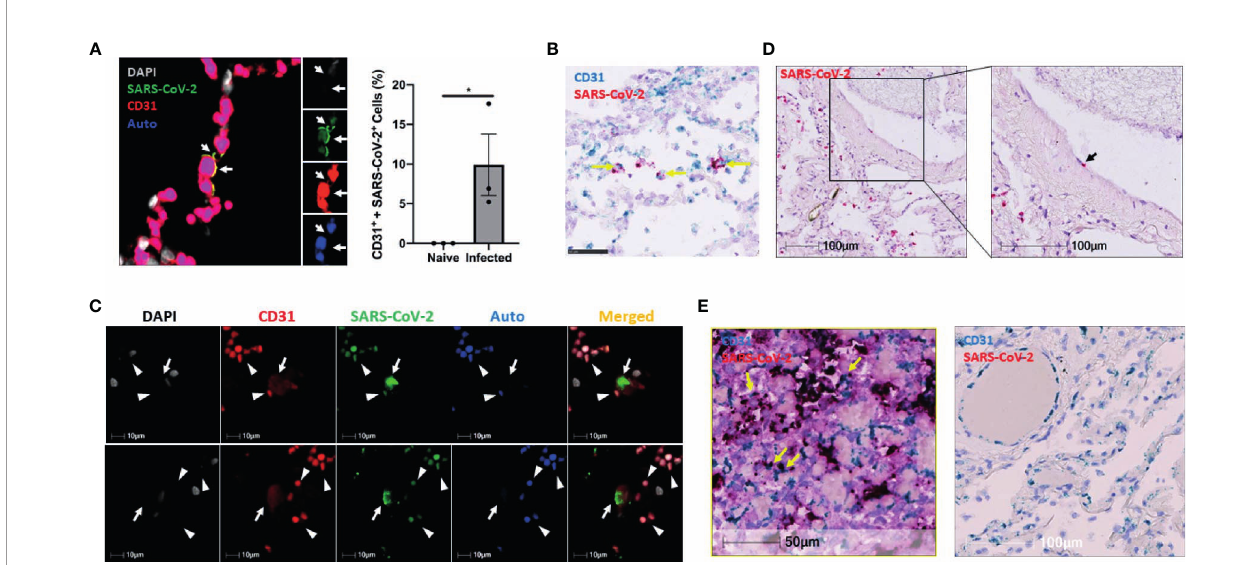
FIGURE 3 | The infection of pulmonary ECs by SARS-CoV-2 in SARS-CoV-2 infected non-human primates and patients who died from severe COVID-19. (A) Representative image (left panel, n = 3) shows colocalization (yellow, arrows) of SARS-CoV-2 (green) and CD31 (red) in the lung of an African green monkey (AGM). Channel separation (right in inset) demonstrates that the SARS-CoV-2 and CD31 signal form an identical pattern, and that there is no auto fl uorescence (blue) in these areas. Quantitative analysis of SARS-CoV-2-infected endothelial cells in the lung of Naïve and infected AGM (right panel). Multilabel immuno fl uorescence histochemistry was used to quantify the proportion of SARS-CoV-2 positive CD31+ endothelial cells in total infected cells in the lung of AGMs (PA16, PA20 and PA24). White=DAPI, green=SARS-CoV-2, red=CD31, and blue=auto fl uorescence. *P < 0.05 vs naïve monkeys by one tail student T test (B) Representative RNAscope image of SARS-CoV-2 and CD31 RNA in the lung of infected AGM (n = 3). Yellow arrows: co-localization of Spike (shown in red) with CD31 (shown in light blue) RNA signal (shown in purple). (C) Colocalization of SARS-CoV-2 with CD31 in two cells (arrows) of a patient that died from COVID-19 (Case 3). Channel separation distinguishes true signal from red blood cells (arrowheads) that lack nuclei (DAPI channel) and can be seen in the auto fl uorescent/empty channel (blue). (D) RNAscope of SARS-CoV-2 RNA (red, black arrow) in the lung of the decreased COVID-19 patient (Case 3) (E) RNAscope of SARS-CoV-2 RNA (red) and CD31 RNA (green) in the lung of Case 2 and Case 1. Co-localization of SARS-CoV-2 RNA with CD31 was found in the lung of Case 2 patient (left panel) but not Case 1 patient (right panel). Yellow arrows: co-localization of Spike (showing in red) with CD31 (shown in light blue) RNA signal (shown in